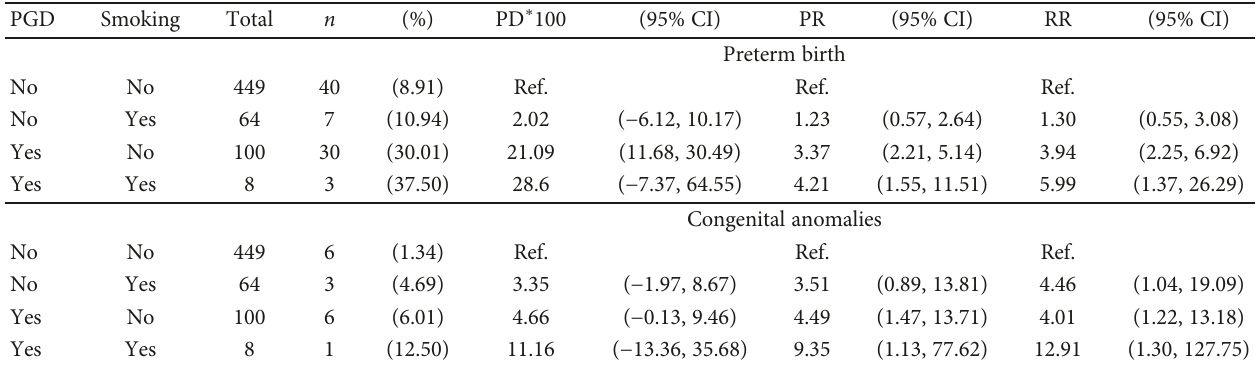
Table 3: Prevalence di ff erence per 100, prevalence ratio and relative risk of preterm birth, and congenital anomalies associated with pregestational diabetes and/or tobacco smoking, Provinces of Modena and Reggio Emilia, 2007 –